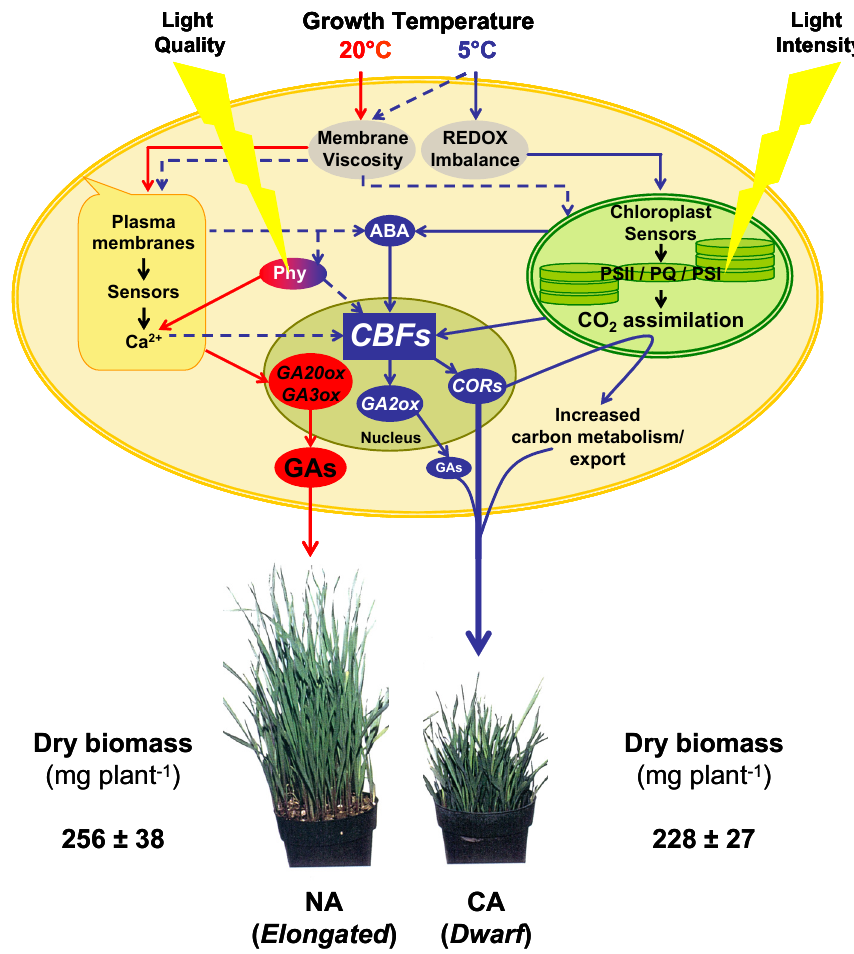
Figure 3. CBFs as integrators of cold acclimation: a schematic model of plant responses to growth temperature of 20 °C and 5 °C (see text for details). ABA—abscisic